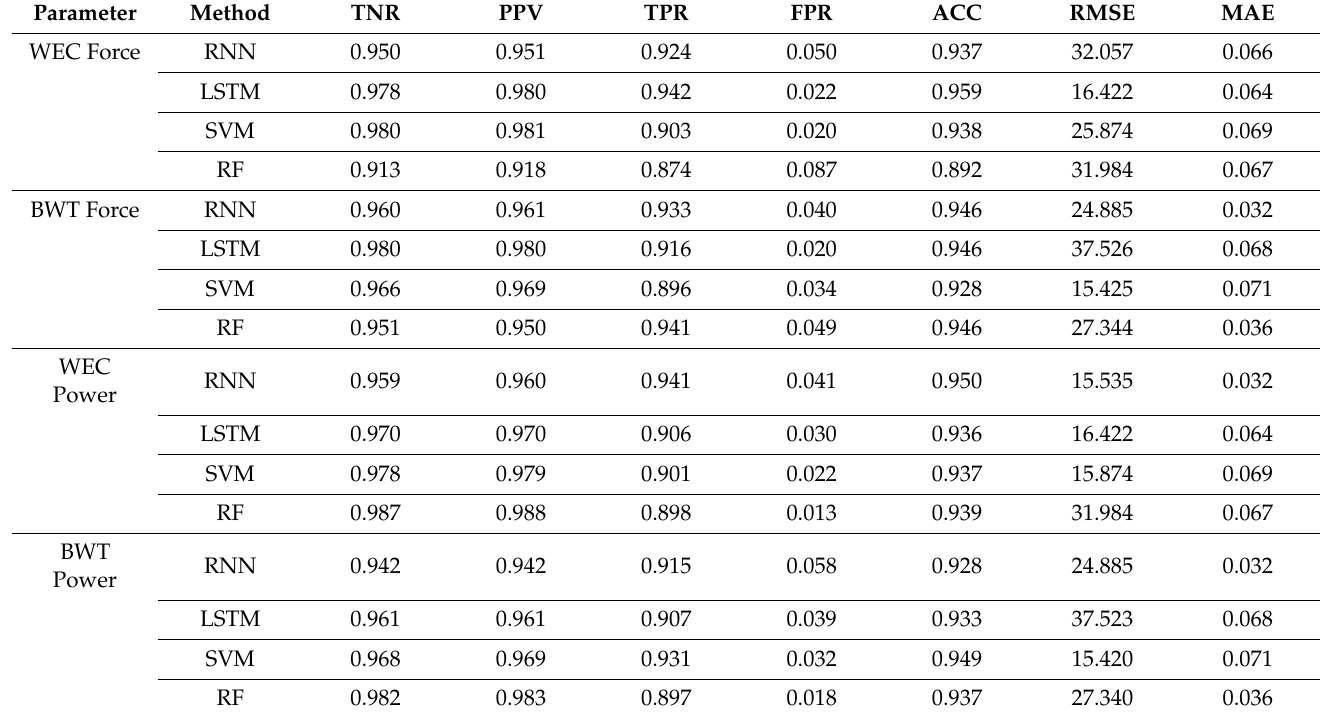
Table 2. Evaluation of machine learning parameters.